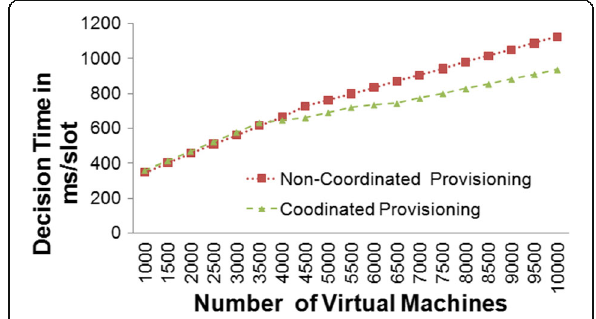
Fig. 7 Provisioning decision time in mili-sec /slot